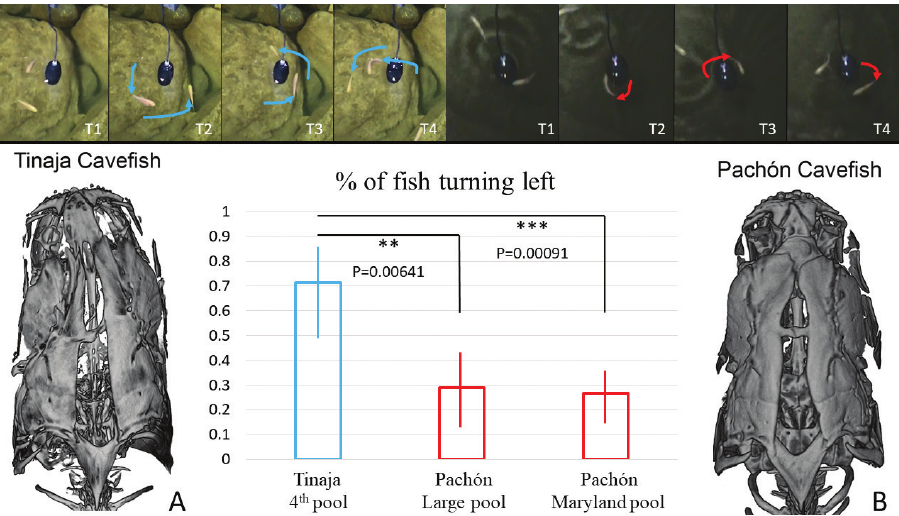
Figure 2. Cavefish explore a vibrating apparatus by circling counterclockwise (T1–T4 left), using their left side, or clockwise (T1–T2 right), using their right side. T1–T4 are sequential images from a video clip with arrows following the path of single fish while circling. Graph shows that preponderant side with which cavefish circle around a vibrating stimulus is significantly different between cave populations (Brackets for 90% confidence) A, B skull images modified from Gross et al. (2014) showing that the left bending of the skull is different between Tinaja and Pachón